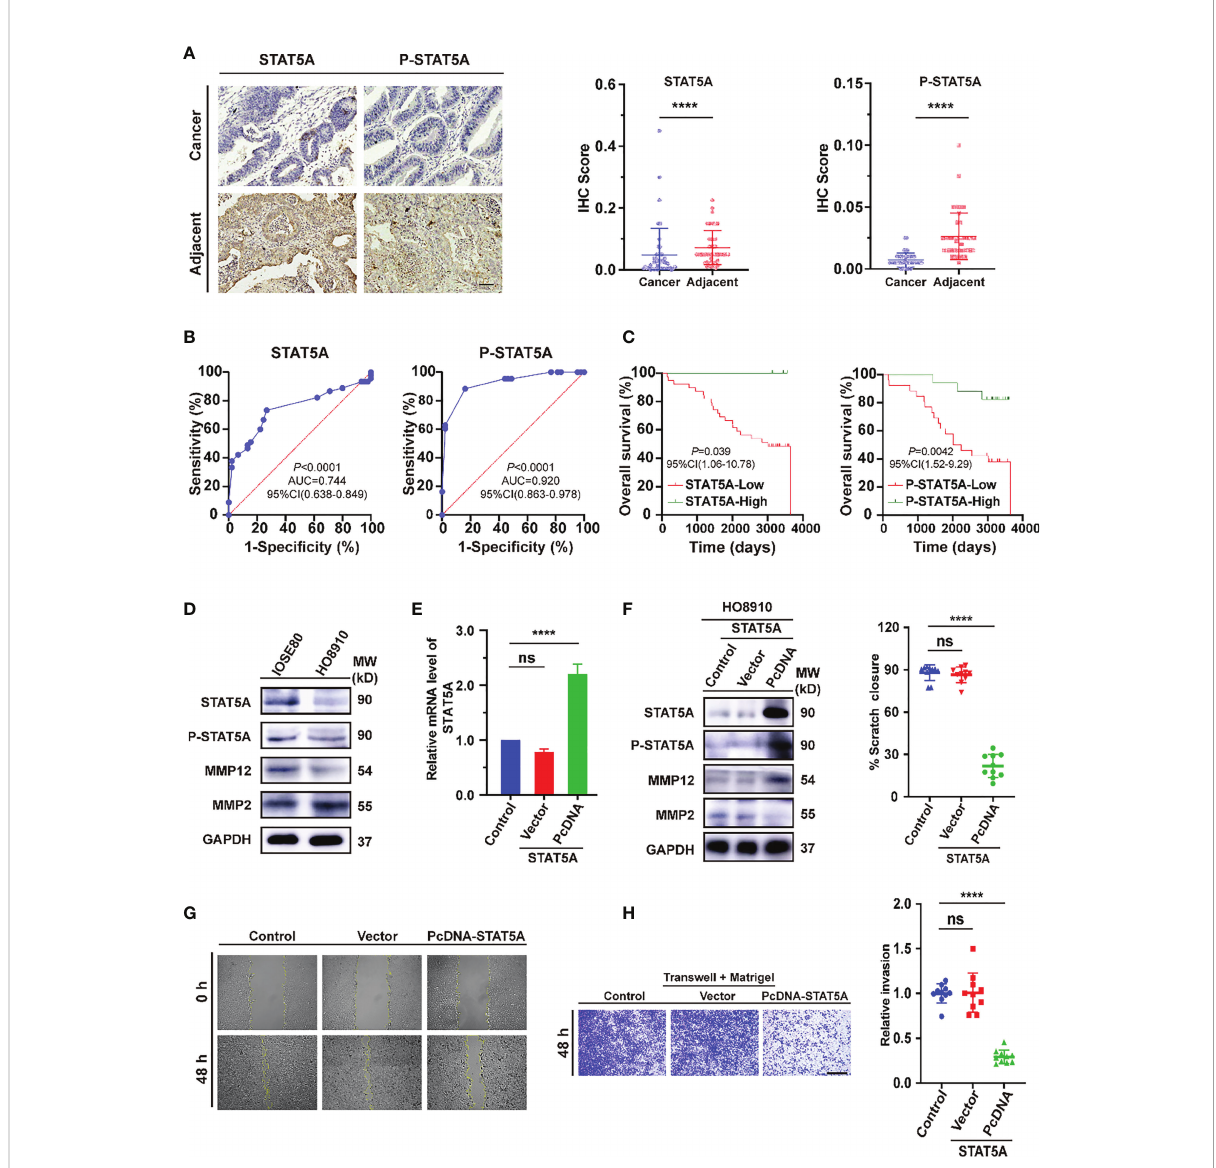
FIGURE 9 Evaluation of STAT5A expression in ovarian cancer tissues and cell lines. (A) Immunohistochemical staining of STAT5A and p-STAT5A on ovarian cancer and adjacent tissues from TMA samples (n=90). Black scale bar, 50 m m. (B) The ROC curves of STAT5A and P-STAT5A are based on independent tests. (C) Kaplan – Meier OS curves based on STAT5A or P-STAT5A level. (D) Immunoblots illustrating the basal expression of STAT5A, P-STAT5A (Tyr 694), MMP12, and MMP2 in the indicated human ovarian serous adenocarcinoma cell (HO8910) and normal ovarian epithelial cell line (IOSE80). (E, F) The mRNA and corresponding protein expression levels of SATAT5A were determined 48 h post-transfection with pcDNA-STAT5A plasmids in HO8910 cells. For normalization, GAPDH was used as an internal reference. MW: molecular weight. (G) Scratch-wound assay to quantify HO8910 cell migration ability. The scratches were recorded at 0 h and 48 h after scratching. Yellow lines indicated the scratched edges. White scale bar, 100 m m. (H) Transwell invasion assay with Matrigel. Cell invasion abilities were measured 48 h after cells or STAT5A overexpressing cells seeding onto a Matrigel-coated transwell fi lter. Black scale bar, 200 m m. **** P <0.0001, ns: not signi fi cantly determined by one-way ANOVA (E, F, H) , Mann-Whitney test (B) , Chi-square test, Kaplan-Meier survival analysis, and Log-rank statistical test (C)